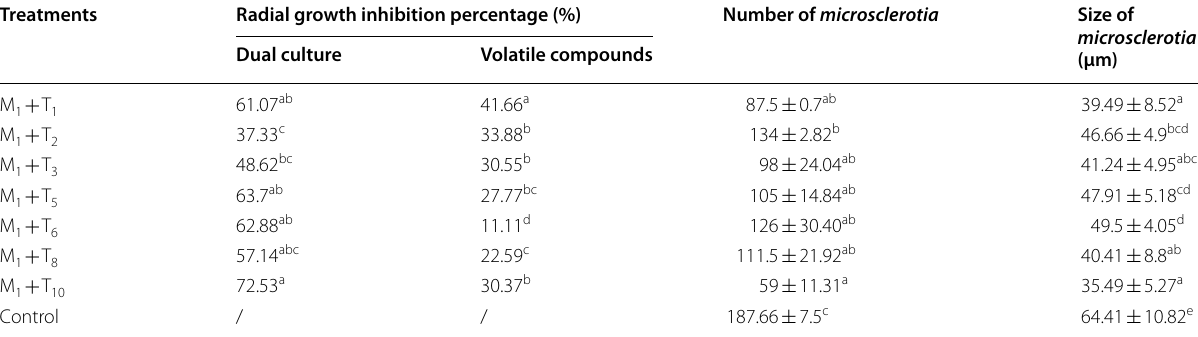
Data shown (mean